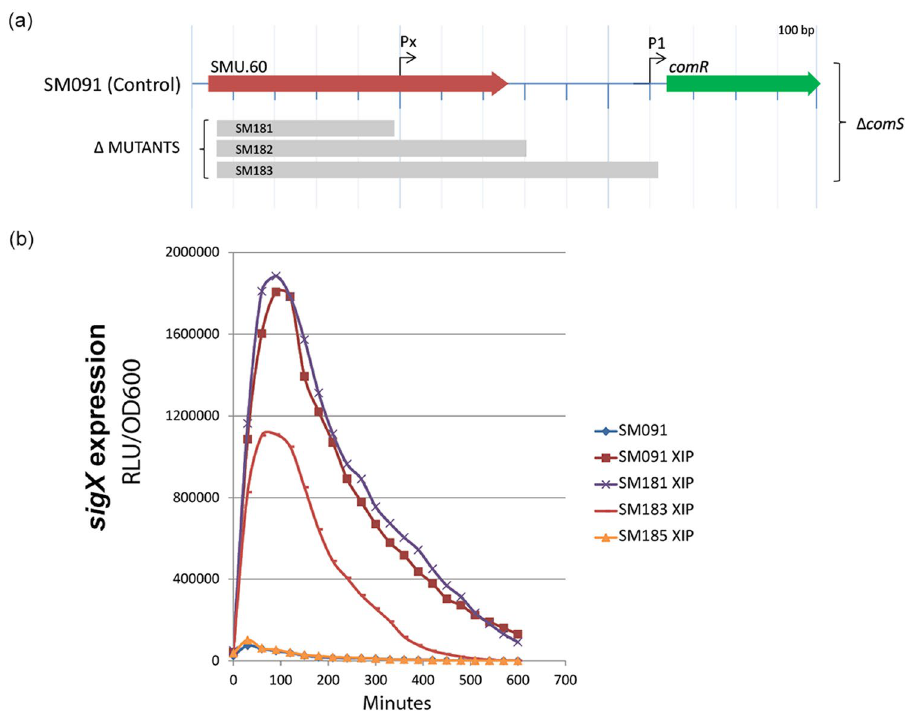
Figure 5. Effect of stepwise deletions upstream of comR on sigX expression. ( a ) Map of the SMU.60 intragenic region exhibiting a putative promoter with a σ x-box (Px; AACGAATA), a predicted comR promoter close to the start of the gene (P1; palindrome sequence TAGTAAATTTACTA), and the regions deleted in the SigX- luciferase reporter mutants SM181, SM183, and SM185, respectively. All the strains were constructed in a Δ comS background. ( b ) sigX expression in response to XIP in the wild type background (SM091), and in the mutants SM181, SM183, and SM186. Luciferase activity was measured in the presence of luciferin, and is presented as relative light units (RLU) per OD600. The results are mean values of 3 experimental replicates, and are representative of 4 independent